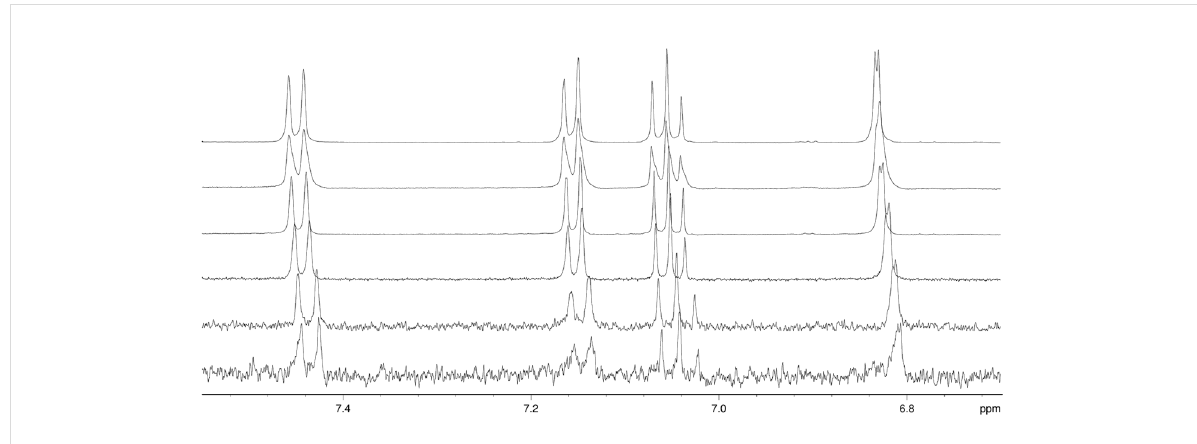
Figure 3: Part of the 1 H NMR spectrum of 2 in [D 6 ]DMSO showing the complexation-induced shifts of the indole CH protons (concentration from bottom to top: 0.4, 1, 6, 12, 25 and 50 mM).